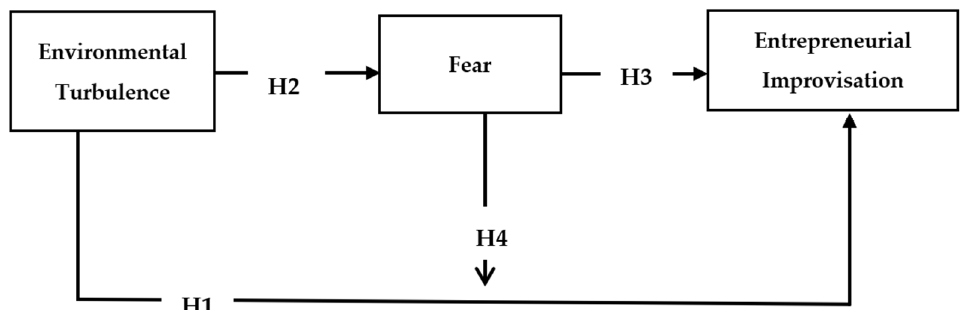
Figure 1. A conceptual framework describing the impact of environmental turbulence on entrepreneurial improvisation through fear.